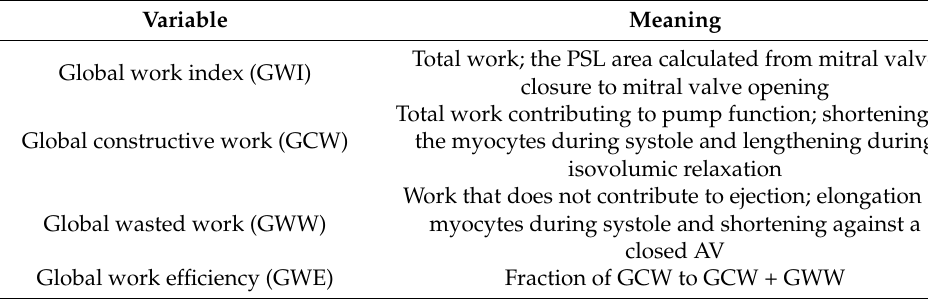
Table 1. Analysis of myocardial work